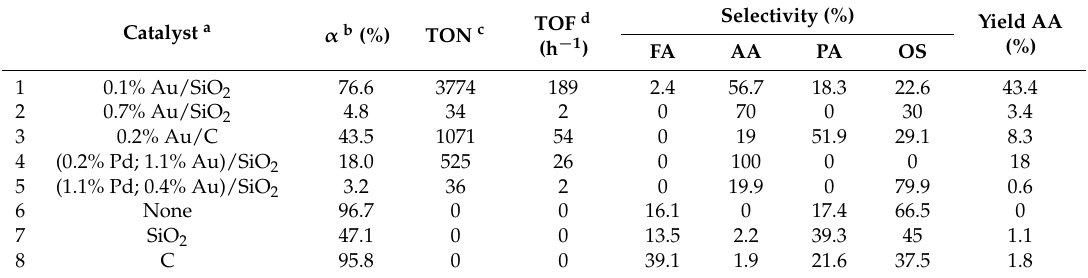
Table 3. Catalytic performance of the resulting catalysts in the oxidation of 1-propanol into acetic acid under reaction conditions as described in Experiment 2.3.